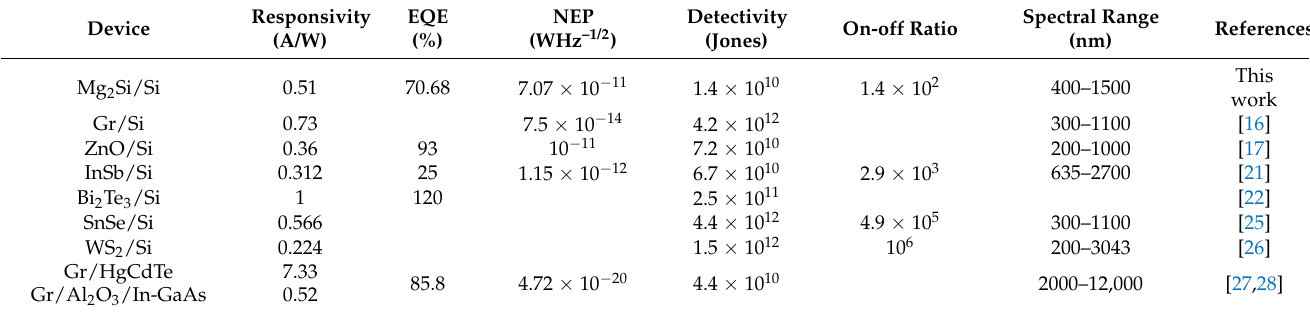
Table 2. Key performance parameters of Mg 2 Si/Si heterojunction PDs and several other reported heterojunction PDs.